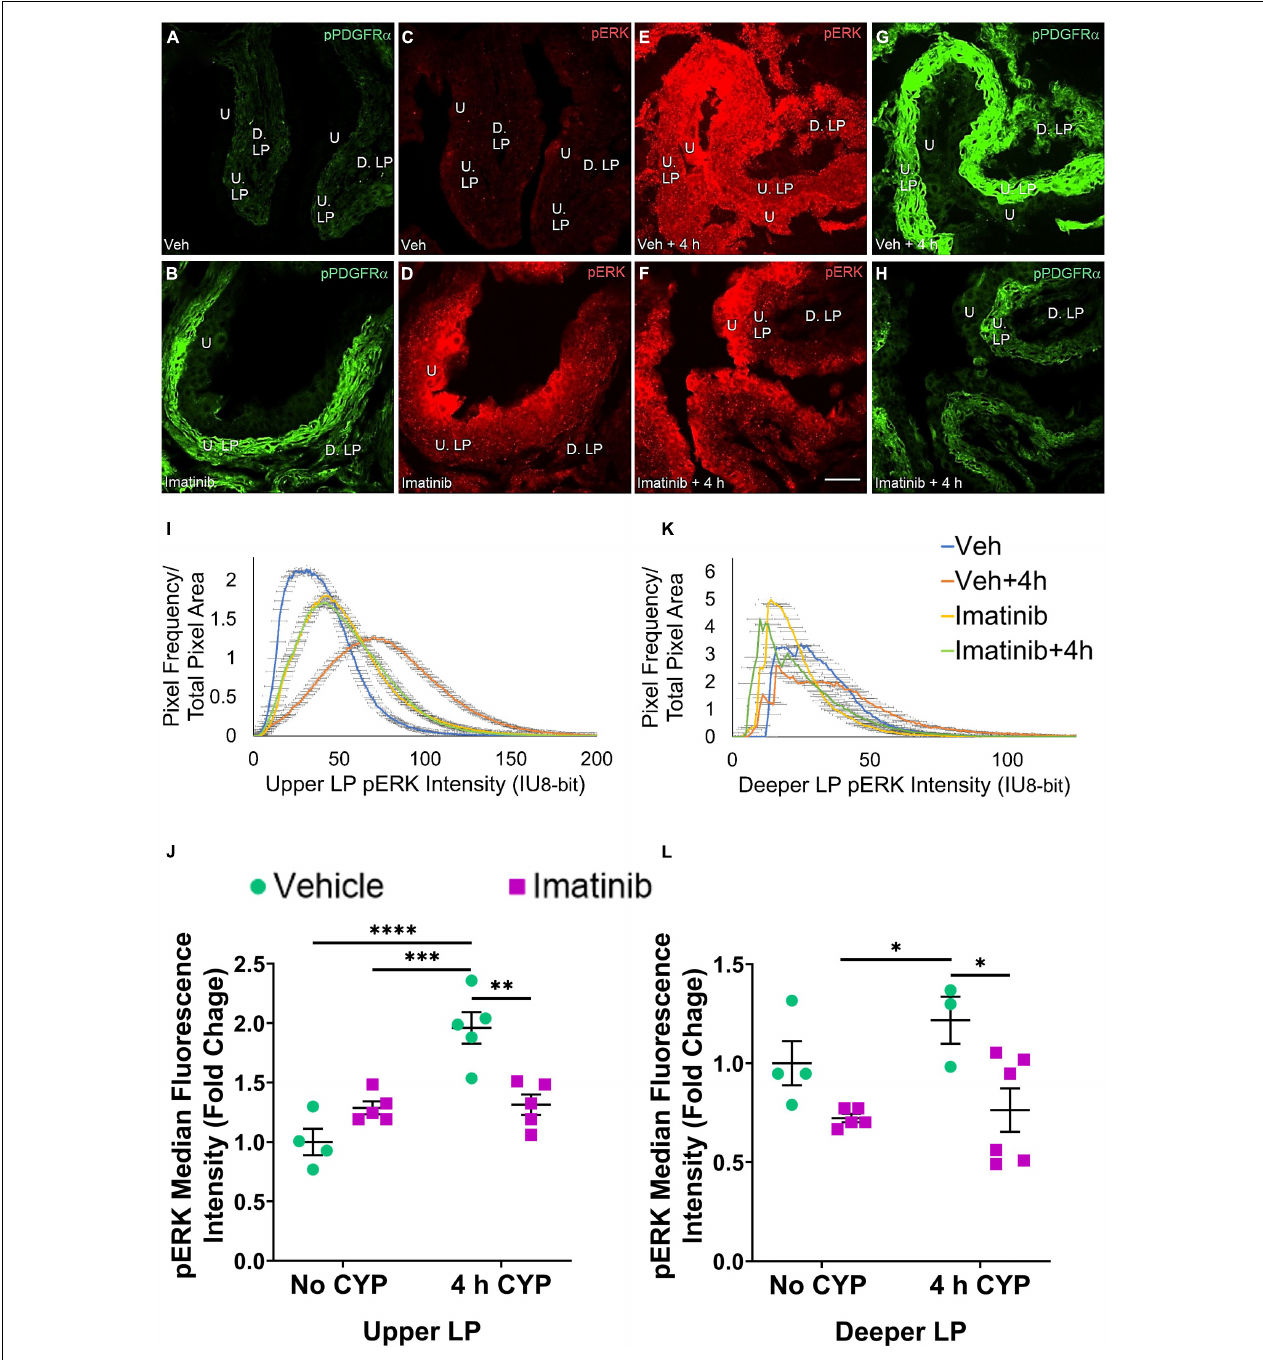
FIGURE 7 | Oral gavage of imatinib mesylate reduces pERK expression in the upper lamina propria (U. LP) and deeper lamina propria (D. LP), in an acute (4 h) cyclophosphamide (CYP)-induced cystitis female mouse model. Representative (A–H) images, (I) upper LP and (K) deeper LP fluorescence intensity curves of pERK immunoreactivity (CY3, red) in the urinary bladder (10 µ m sections) in female mice with (E) acute (4 h) cyclophosphamide (CYP)-induced cystitis (200 mg/kg, i.p.) and (C,D) controls (no CYP), (F) pre-treated with imatinib mesylate via oral gavage (250 mg/kg, 5 days, 1X/day). (A,B,G,H) Bladder tissue was co-stained for pPDGFR α (FITC, green), and the corresponding images are displayed to provide orientation. 4 h CYP treatment significantly ( p ≤ 0.0001) increased pERK expression in the (J) U. LP (2-fold) but not the (L) D. LP, compared to vehicle controls. Imatinib prevention significantly (0.01 ≤ p ≤ 0.05) reduced pERK expression in the (J) U. LP (1.5-fold) and the (L) D. LP (1.6-fold) in female mice with 4 h CYP-induced cystitis. Raw IHC values (intensity units, 8-bit) are presented as fold change values ± SEM with respect to the control group (vehicle, no CYP). n = 3–6. * p ≤ 0.05; ** p ≤ 0.01; *** p ≤ 0.001; **** p ≤ 0.0001 by two-way ANOVA with Tukey’s multiple comparisons test. Tissues were processed simultaneously. Microscope and camera settings were kept constant across all groups. Fluorescence intensity was measured using Volumetry image analysis software (VolumetryG9a, Grant Hennig). 10 µ m sections. Scale bar = 50 µ m. U, urothelium; U. LP, upper lamina propria; D. LP, deeper lamina propria; IU, intensity